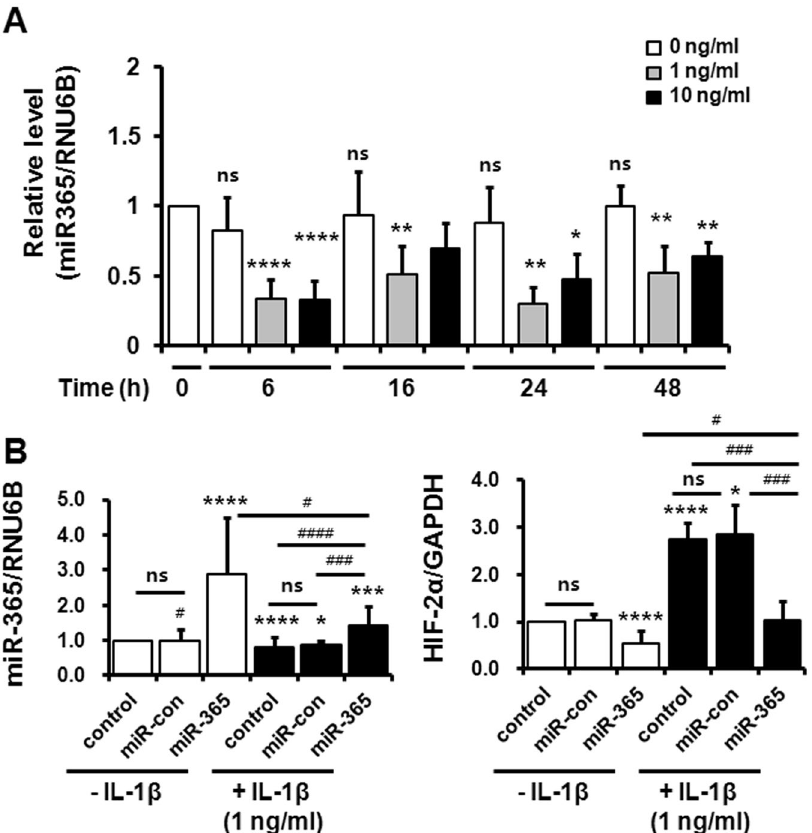
Figure 2. miR-365 significantly inhibits interleukin (IL)-1 β -induced HIF-2 α expression. ( A ) The effect of IL-1 β on miR-365 expression in human OA chondrocytes. Human chondrocytes were exposed to IL-1 β (1 or 10 ng/mL) for 6, 16, 24, and 48 h. Expression of miR-365 was measured using TaqMan miRNA real-time PCR assays. RNU6B was used as an endogenous control. Data are expressed as the mean ± SD of duplicate data from six independent experiments. ns, not significant, * P < 0.05, ** P < 0.01 and **** P < 0.001 vs . IL-1 β -untreated cells. ( B ) Inhibitory effect of miR-365 on IL-1 β -induced HIF-2 α expression. Human chondrocytes were transfected with miR-365 or a nonspecific miRNA control (miR-con) for 48 h and stimulated with IL-1 β for 6 h. Expression of miR-365 and HIF-2 α was measured using TaqMan miRNA and SYBR Green-based real-time PCR assays, respectively. RNU6B and GAPDH were used as endogenous controls. Data are expressed as the mean ± SD of duplicate data from more than three independent experiments. ns, not significant; * P < 0.05, *** P < 0.005, and **** P < 0.001 vs . IL- 1 β -untreated control; # P < 0.05, ### P < 0.005, #### P < 0.001 vs . IL-1 β + miR-365-transfected